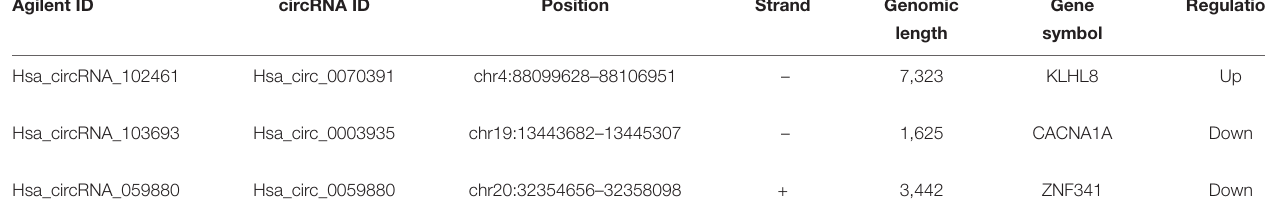
TABLE 1 | The basic characteristics and structure patterns of these three circRNAs. Agilent ID